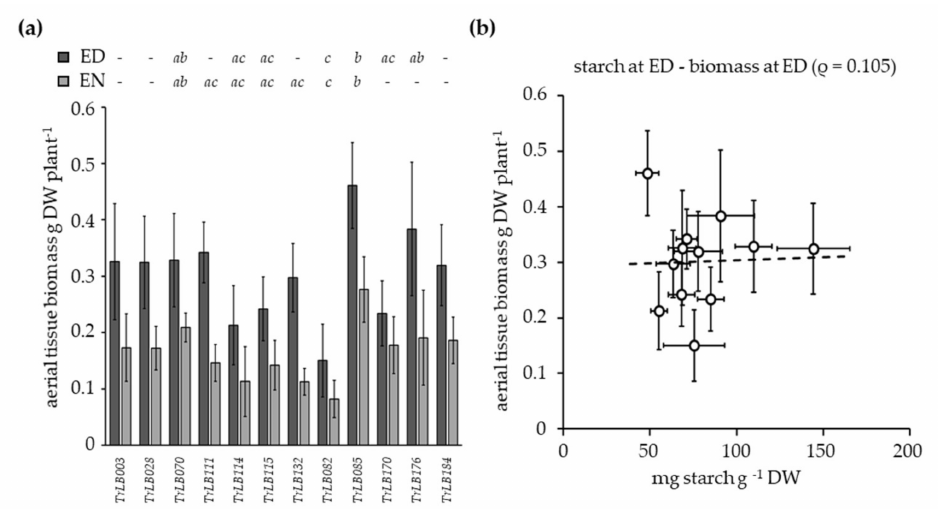
Figure 7. Relationship of starch and biomass in 12 selected genotypes, each represented with 10 clonal replicates. ( a ) Aerial biomass of the 12 genotypes described in Figure 6. Dry weights were determined at ED and at EN. The letter pairs ( a–c ) indicate significant differences in biomass between genotypes ( p = 0.05) derived from analysis of variance and Tukey’s HSD post-hoc comparisons. ( b ) The relationship between starch content and biomass at ED in clonal genotypes. The dash (–) indicates no significant difference as described for Figure 6. Error bars indicate 95% confidence